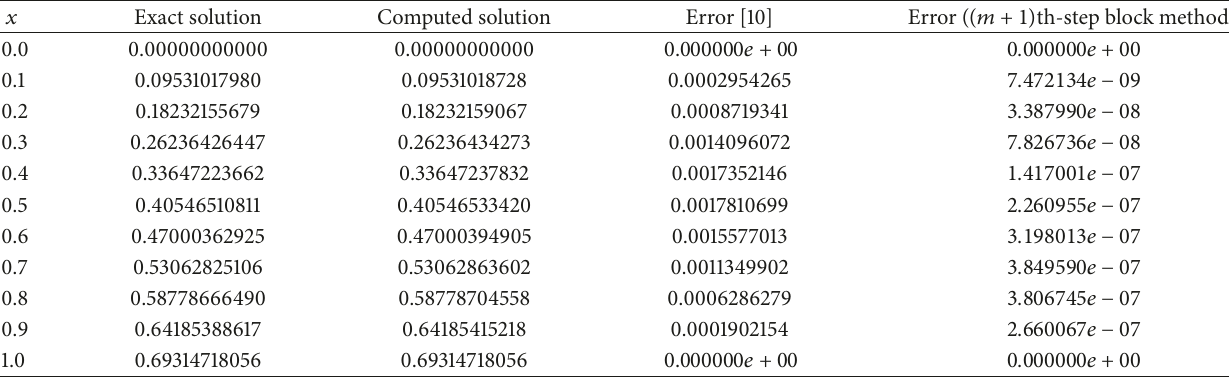
Table 1: Comparison of the (𝑚 + 1) th-step block method with Mustafa et al. [10] for solving Example 7.